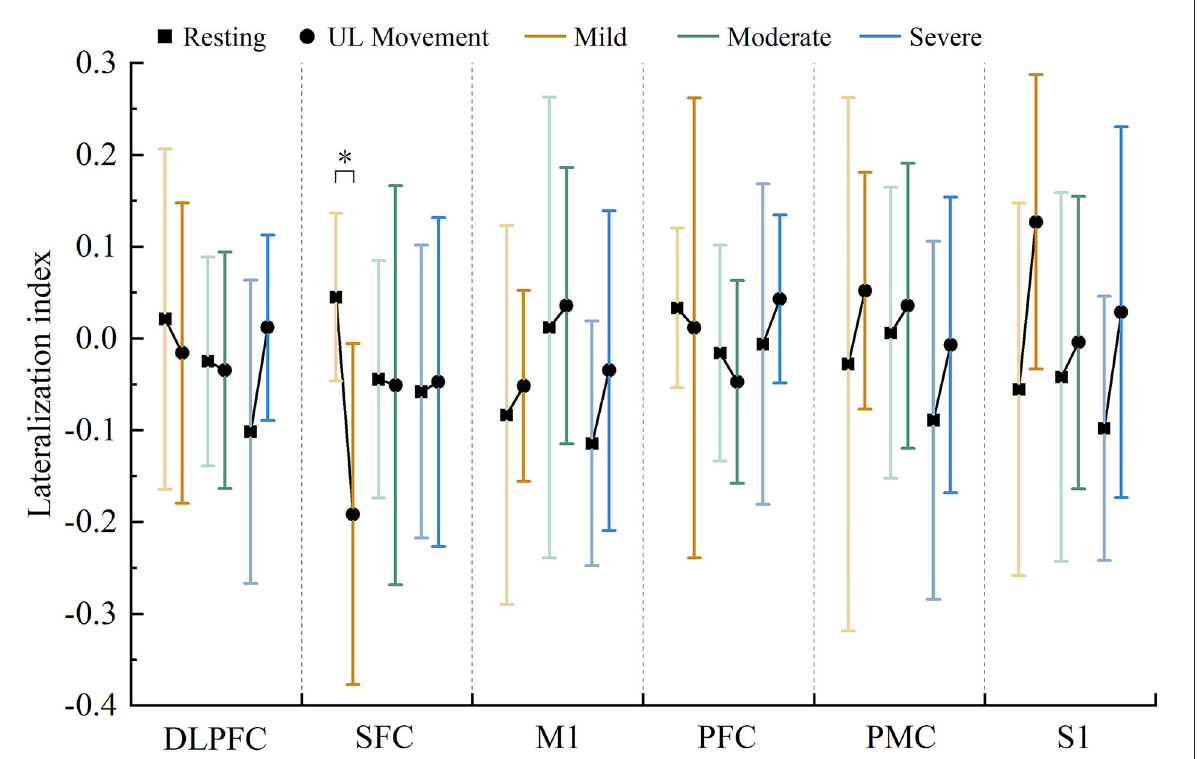
FIGURE4 Changes in the LI value in each region under resting state and motor training state in patients with mild (red), moderate (green), and severe (blue) motor dysfunction (* p <